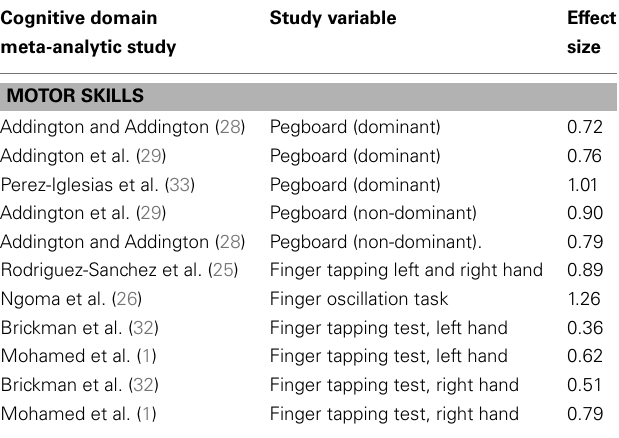
Table 5 | Studies comparing patients with first-episode psychosis and healthy controls on motor speed